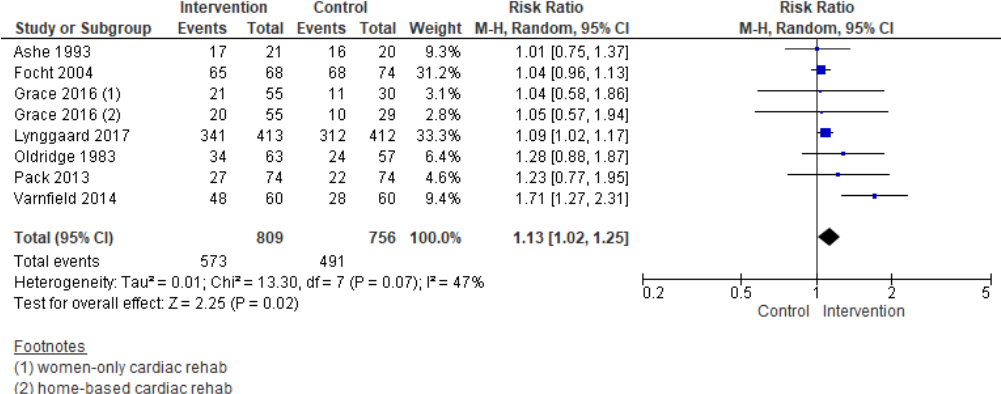
Figure 8. The effect of cardiac rehabilitation utilization interventions on program completion. Note: Boxes represent the risk ratio (RR) for individual trials. The boxes are proportional to the weight of each study in the analysis and the lines represent their 95% confidence interval (CI). The diamond represents the pooled RR, and its width represents its 95% CI.